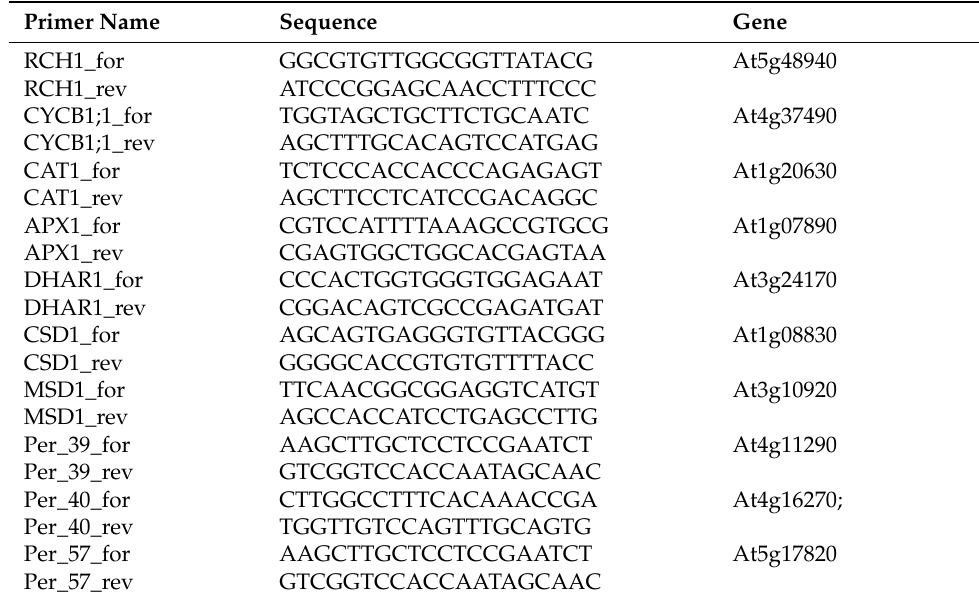
Table 1. List of the primers used for